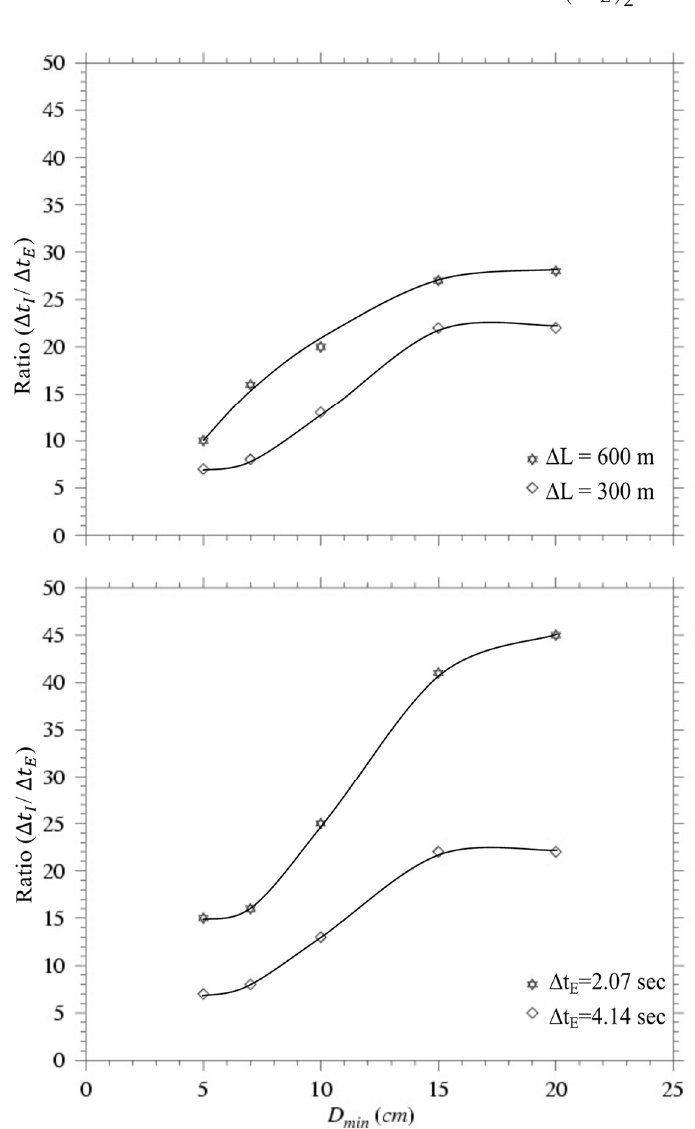
Figure 10. The model-derived relationship of ∆ t I / ∆ t E with ∆ L (upper panel) and ∆ t E (lower panel). In the upper panel case, ∆ t E = 4.14 s, α = 7.0 × 10 − 4 , kb = 6, and ζ o = 1.5 m. In the lower panel case, ∆ L = 300 m, α = 7.0 × 10 − 4 , kb = 6, and ζ o = 1.5 m.